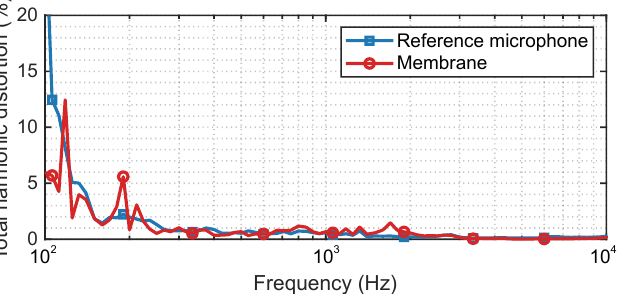
Figure 8. THD spectrum obtained by the reference microphone and the membrane specimen.